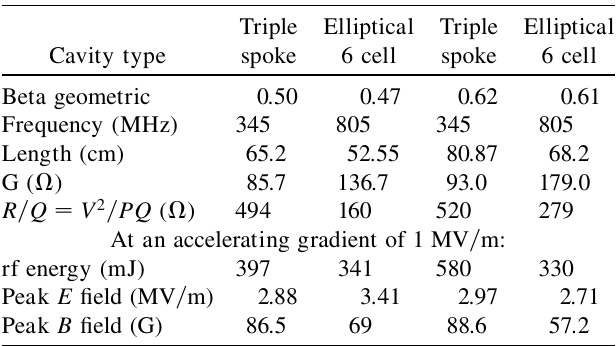
TABLE II. Electromagnetic parameters for the two triple- spoke cavities compared with two elliptical-cell 6-cell cavities of similar geometric (cid:3) (cid:1) v=c developed for the SNS linac and for the RIA driver linac.